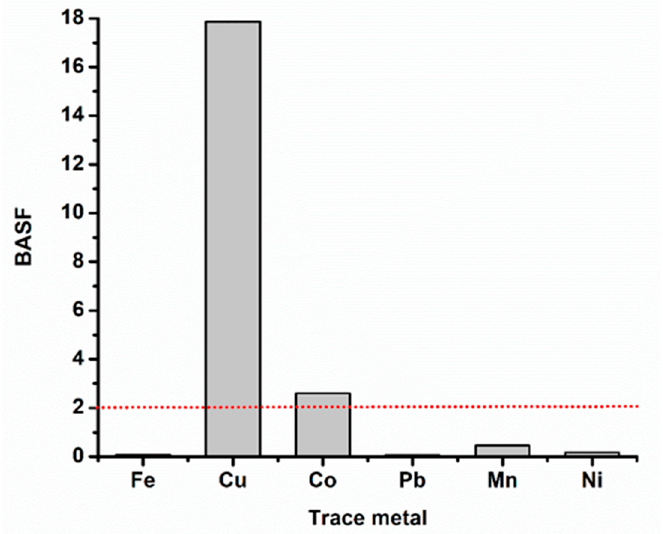
Figure 3. Biota sediment accumulation factors (BSAF) for Strombus canarium at Libong Island.